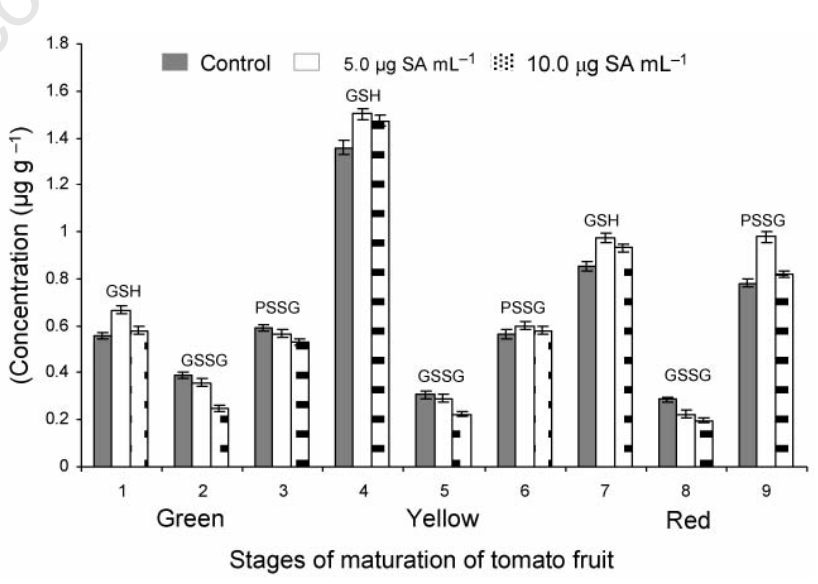
Figure 1. Free and bound glutathione in tomato crop as affected by foliar application of salicylic acid.